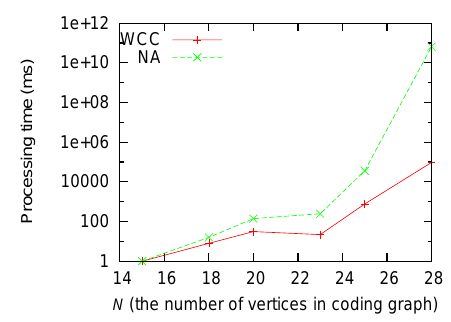
Figure 3. Processing time sensitivity to N .